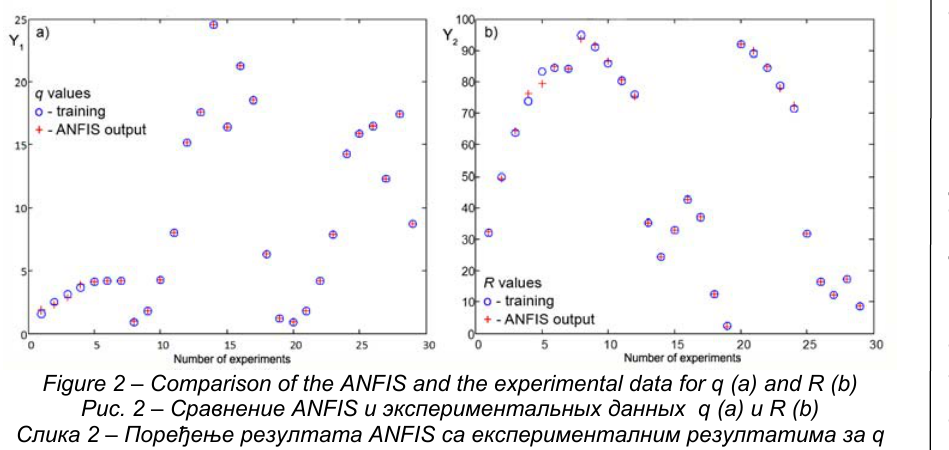
Figure 2 – Comparison of the ANFIS and the experimental data for q (a) and R (b) Рис . 2 – Сравнение ANFIS и экспериментальных данных q (a) и R (b) Слика 2 – Поређење резултата ANFIS са експерименталним резултатима за q